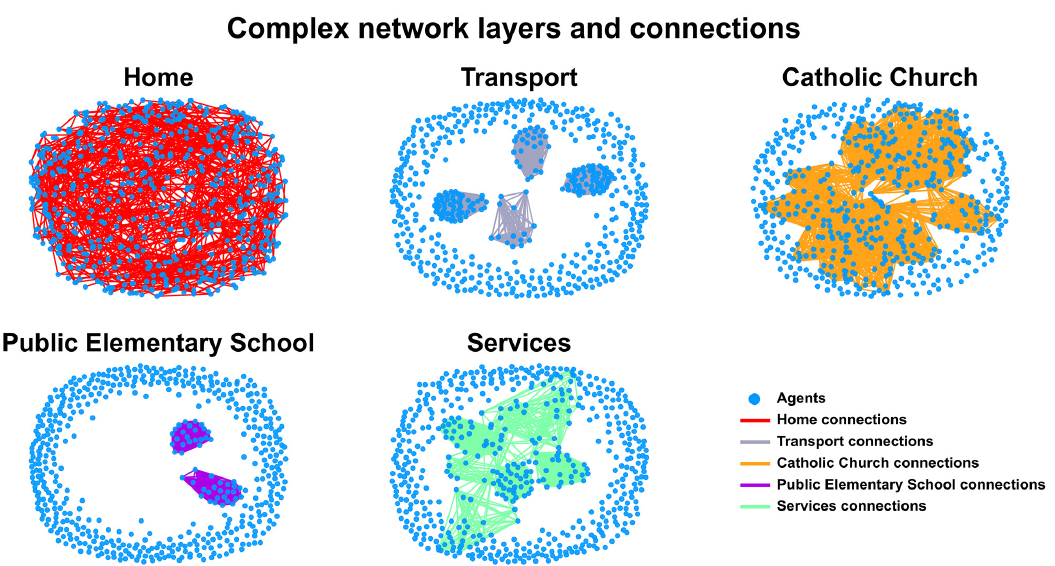
Fig 2. High diversity of contact networks. Layers and sub-layers are complex networks composed of agents (blue dots) and social interactions (lines). Representative layers (Home and Transportation) and sub-layers (Catholic churches, Public Elementary Schools and Services) display different characteristics as high connectivity, coverage and a small world topology. All the information about connections is available in Table